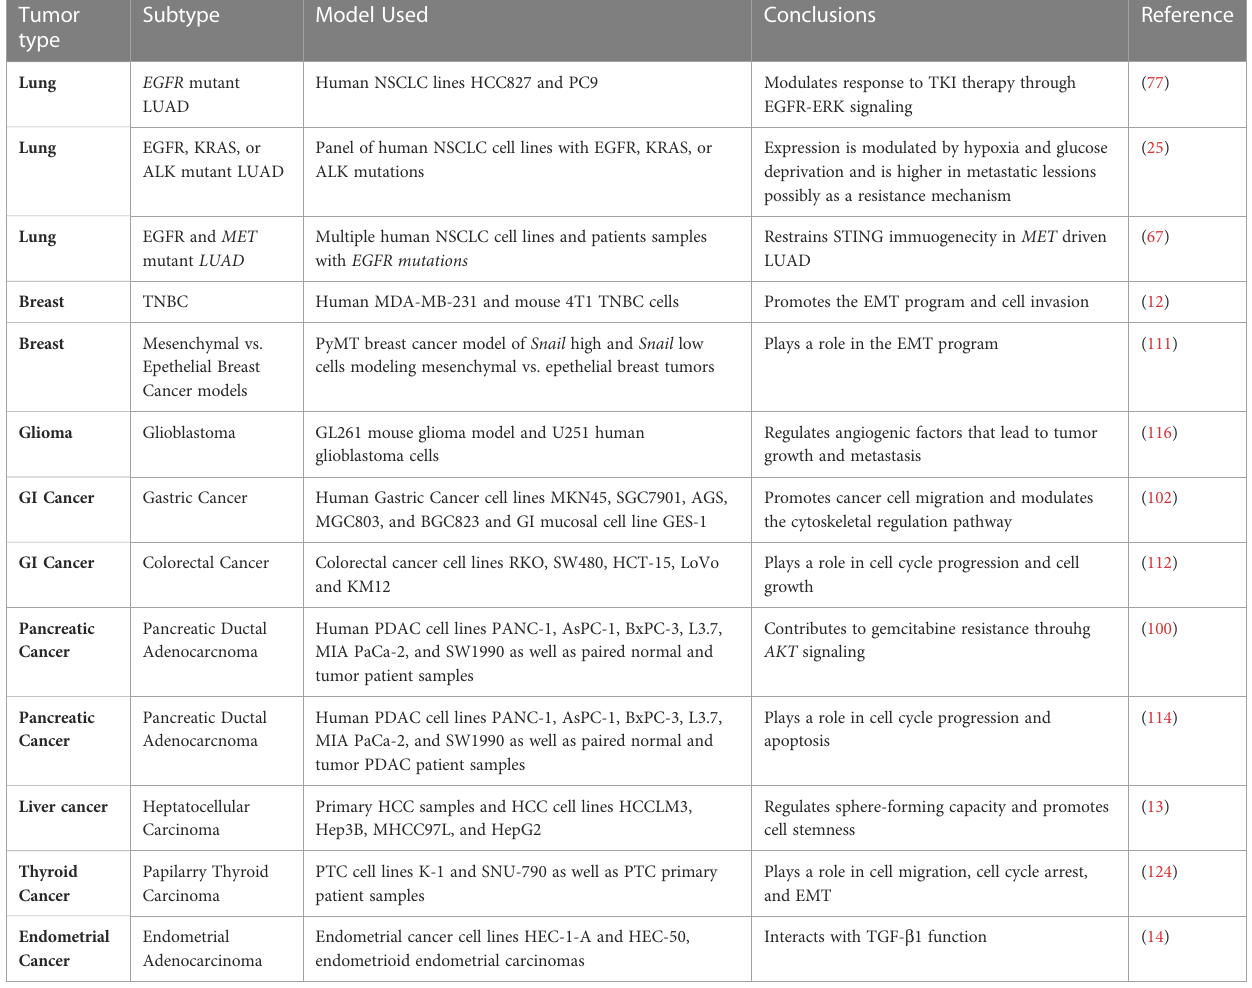
TABLE 1 Recent studies highlighting tumor cell intrinsic functions of